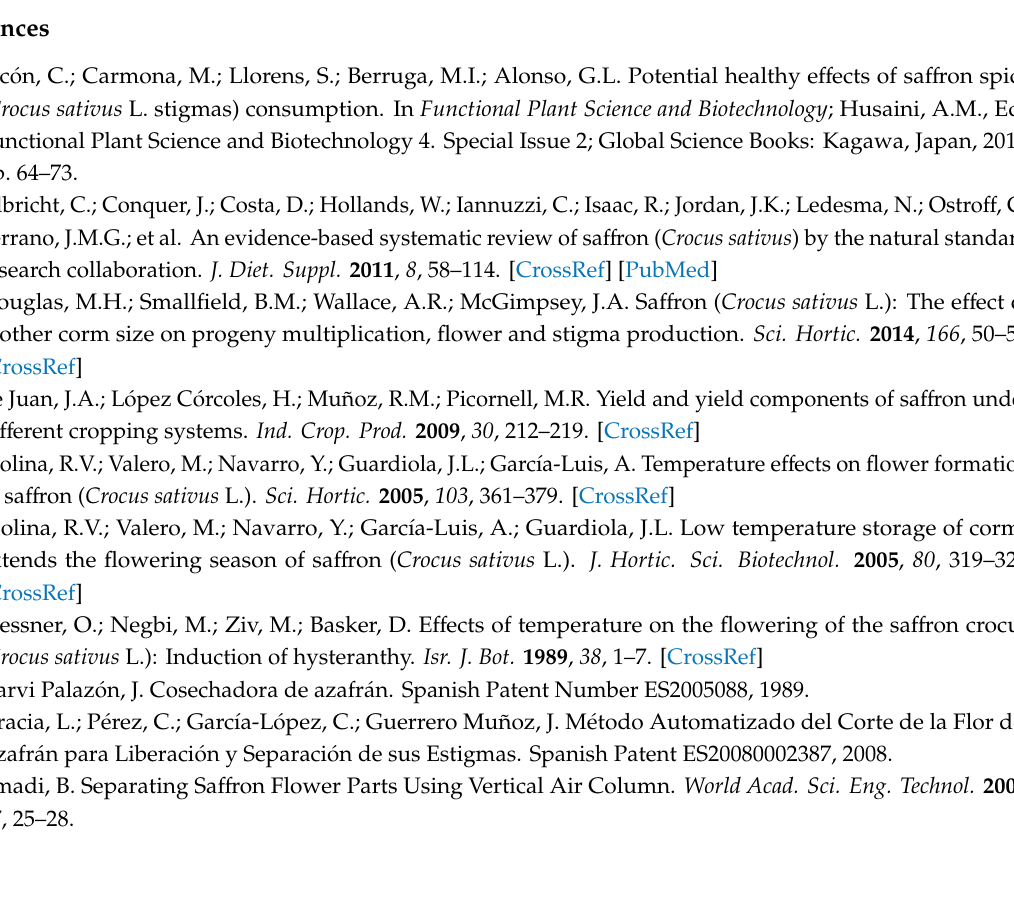
Table S1: Mean value of the parameters analysed and level of significant di ff erences for the studied factors and their interactions, season